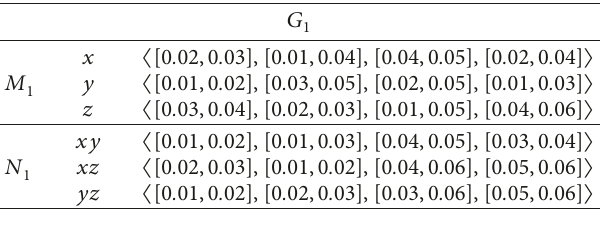
Table 3: The degree of MV and N-MV of the nodes and edges in G